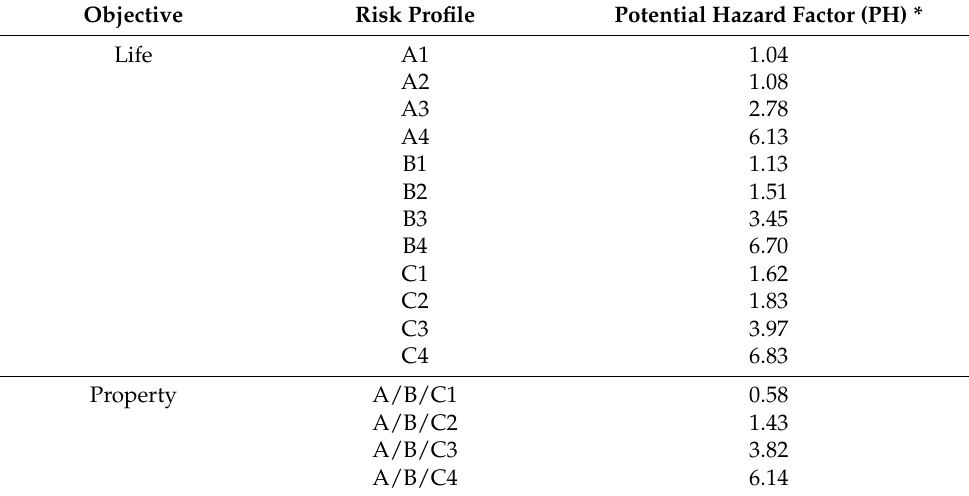
Table 6. Potential hazard factors appropriate for building risk